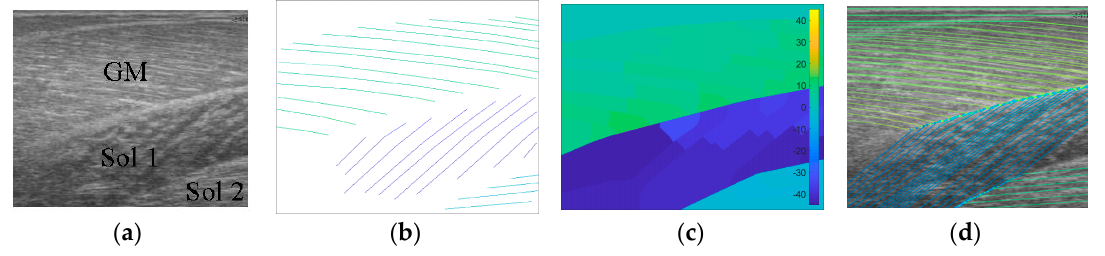
Figure 7. Image annotation. ( a ) shows the raw ultrasound image and 3 muscles/compartments (Grey model (GM), Sol 1 and Sol 2), ( b ) shows expert annotated line traces of visible fibre paths, ( c ) shows nearest neighbour region filling of annotated fibre paths within annotated muscles/compartments, ( d ) shows line traces over the filled regions.